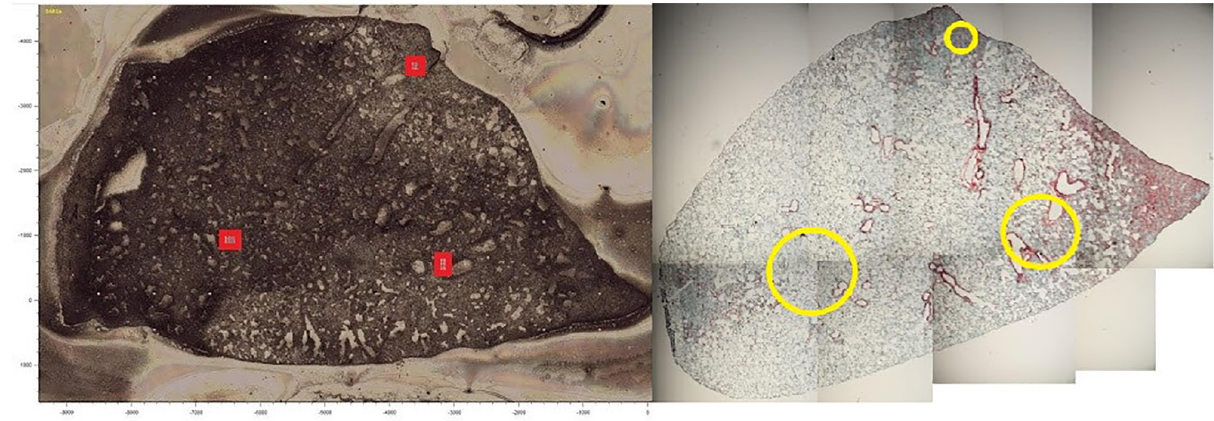
Fig 1. Region matching between Raman bright field images and IHC images. Left: Image of murine lung showing region of Raman acquisition maps (red squares). Right: Mouse lung showing corresponding regions(yellow circles) where pathological grades were assessed.